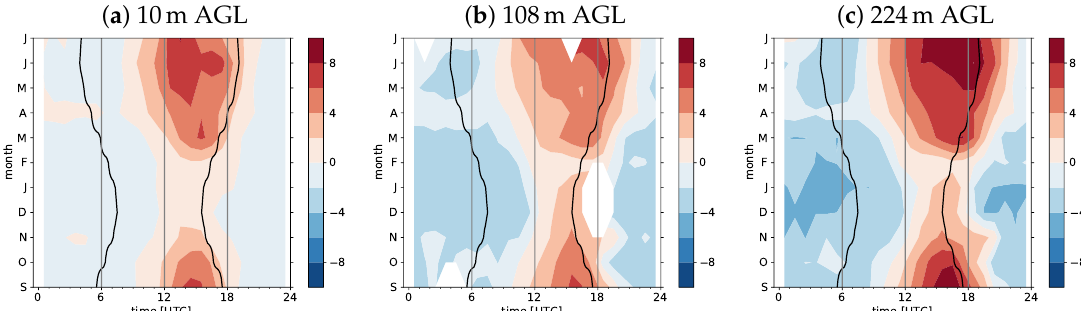
Figure 11. Along-valley wind speed (color, vector-averaged) as a function of time of day and month for the weather station data ( a ) and the low-mode wind profiler data at different altitudes ( b , c ). The bold lines denote the time of local sunrise and sunset (on the 15th of each month), respectively.